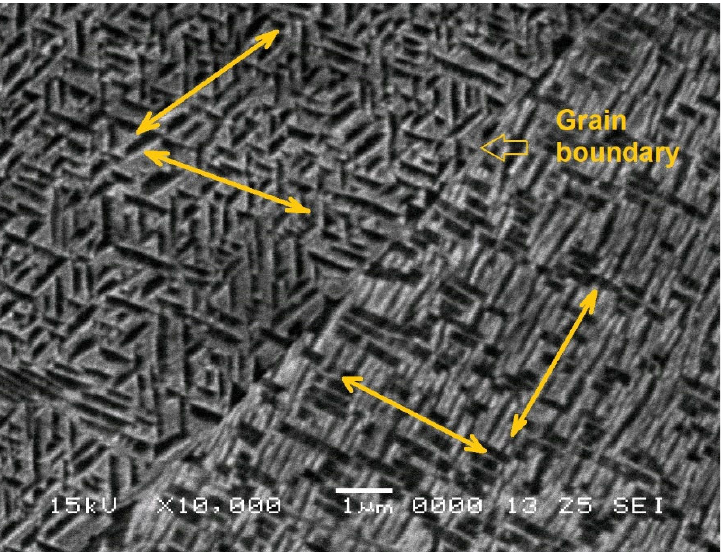
Figure 6. Detail of the SEM micrograph of specimen 10 h–10 Hz, from Figure 5i, emphasizing the crystallographic directions of the crystallites on both sides of a grain boundary.